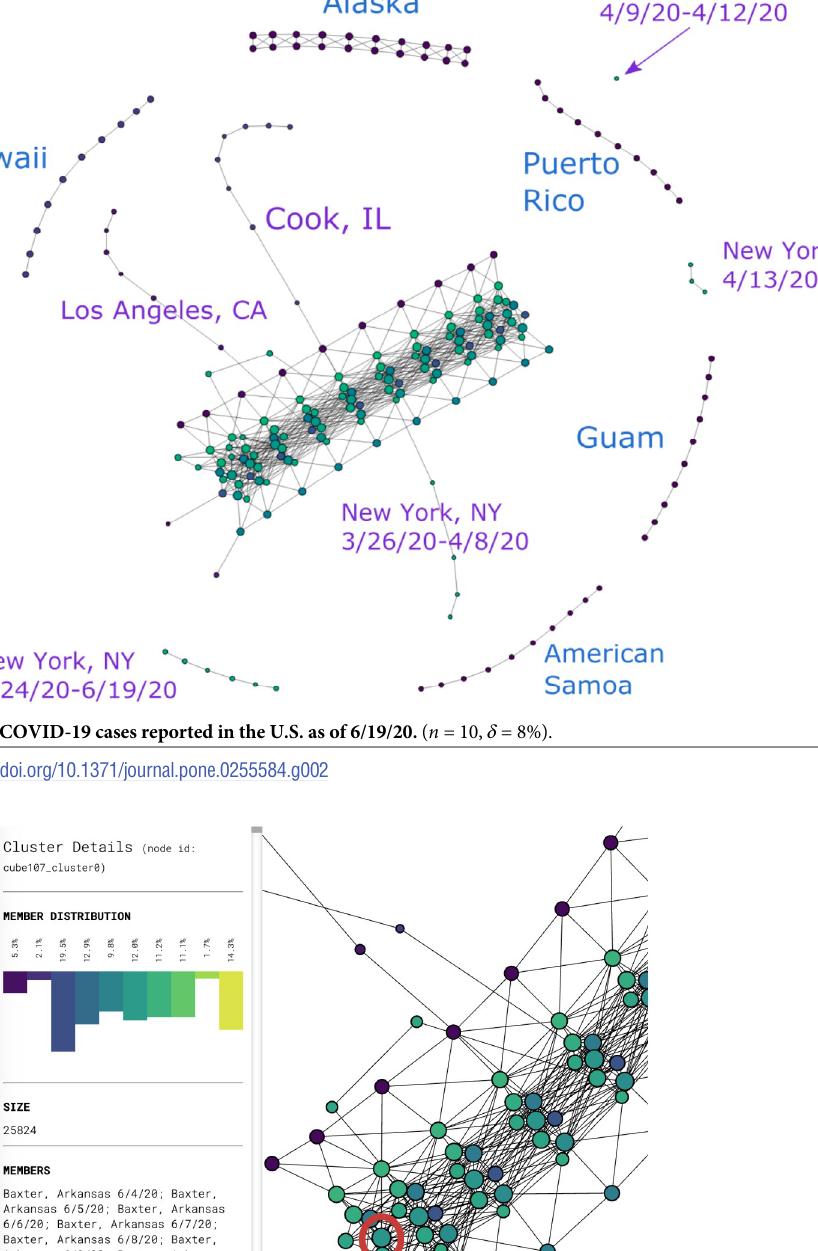
PLOS ONE | https://doi.org/10.1371/journal.pone.0255584 August 4,